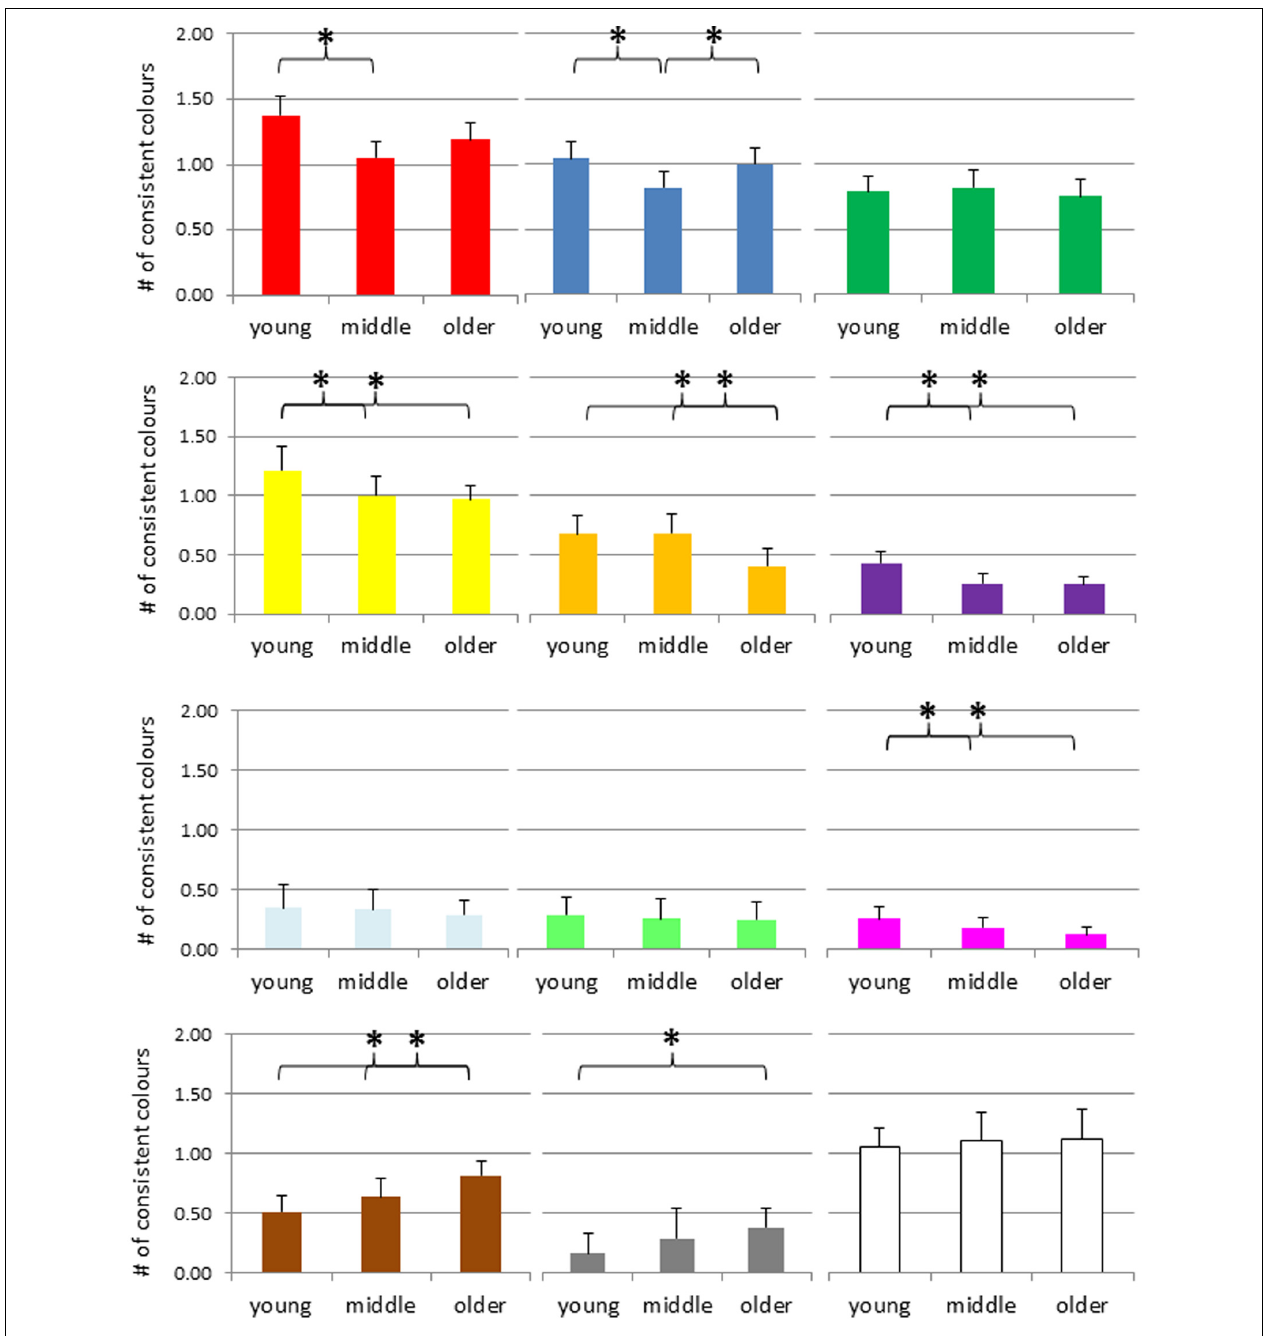
FIGURE 4 | Number of consistent colors for digits across the adult lifespan, separately for each color (red, blue, green, yellow, orange, violet, light-blue, light-green, magenta, brown, gray, and white from top left to bottom right). * p < 0.05, # = number.